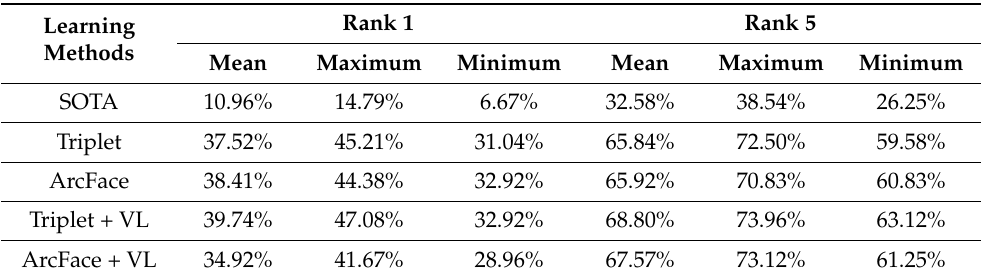
Table 4. Results of mean, maximum, and minimum accuracy of rank 1 and rank 5 for the learning methods in face